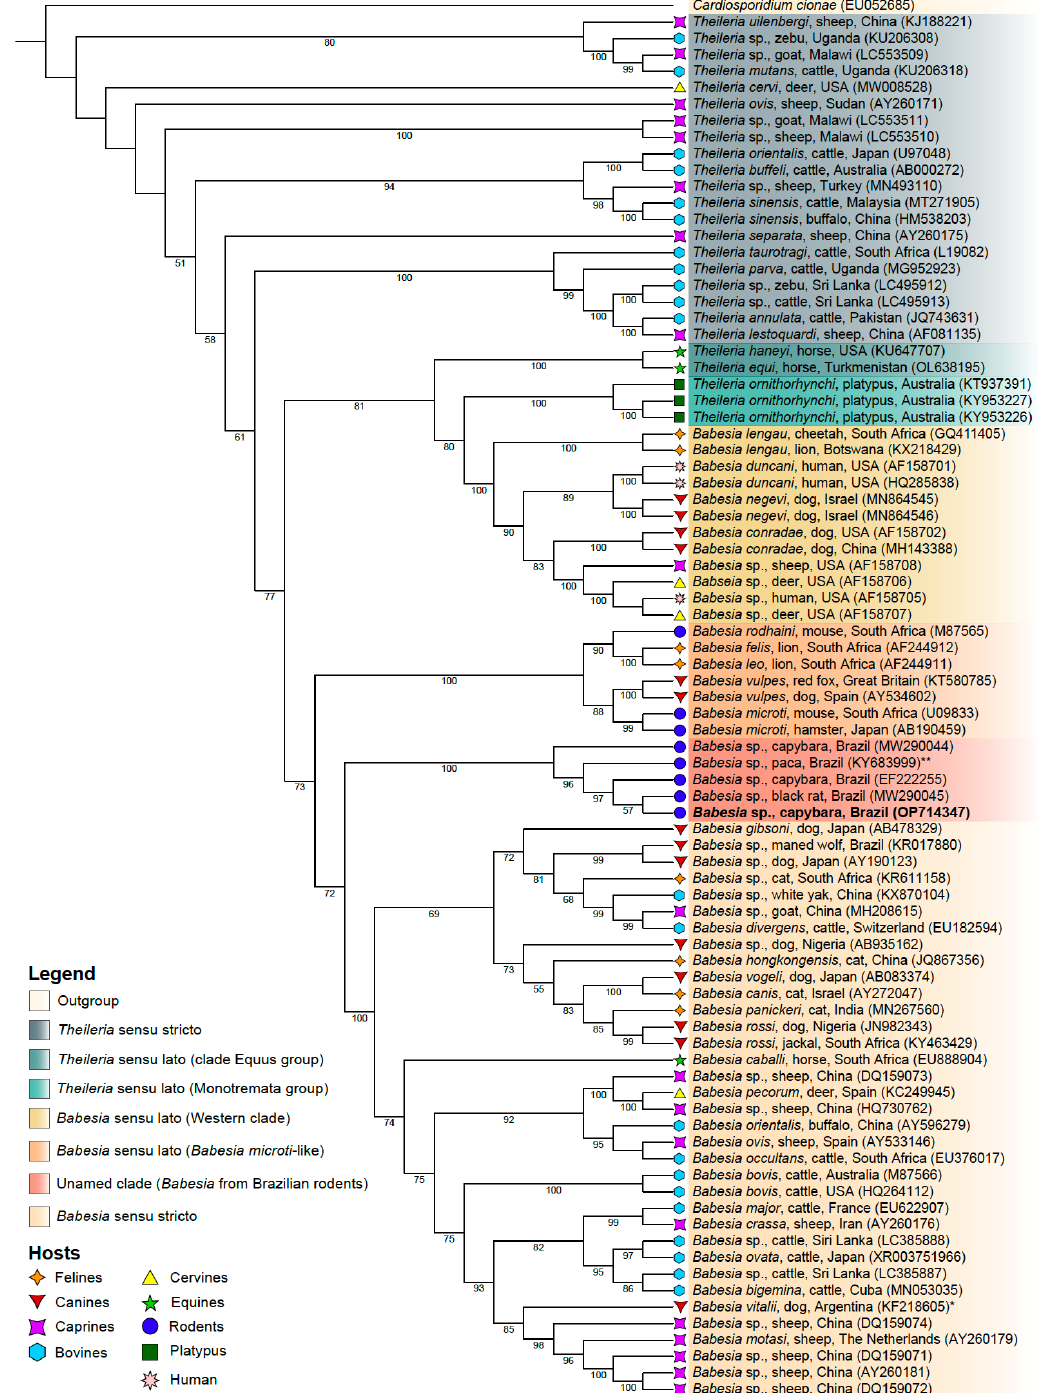
Figure 2. Phylogenetic reconstruction of Theileria and Babesia species based on a 610-bp alignment of the 18S rRNA gene. Maximum likelihood tree inferred using TN + F + I + G4 evolutive model. The support of branches above 50 is shown (based on 1000 bootstrap replicates). Symbols at branch tips refer to the hosts from which parasites were detected. The sequence generated in the present study is highlighted in bold. The 18S rRNA gene sequence (EU052685) of Cardiosporidium cionae (Van Gaver and Stephan, 1907) was used as an outgroup. Sequences marked * or ** are referred to as Rangelia vitalii (Pestana, 1910) and Theileria sp. in GenBank, respectively. The nomenclature of the clades is according to Jalovecka et al.